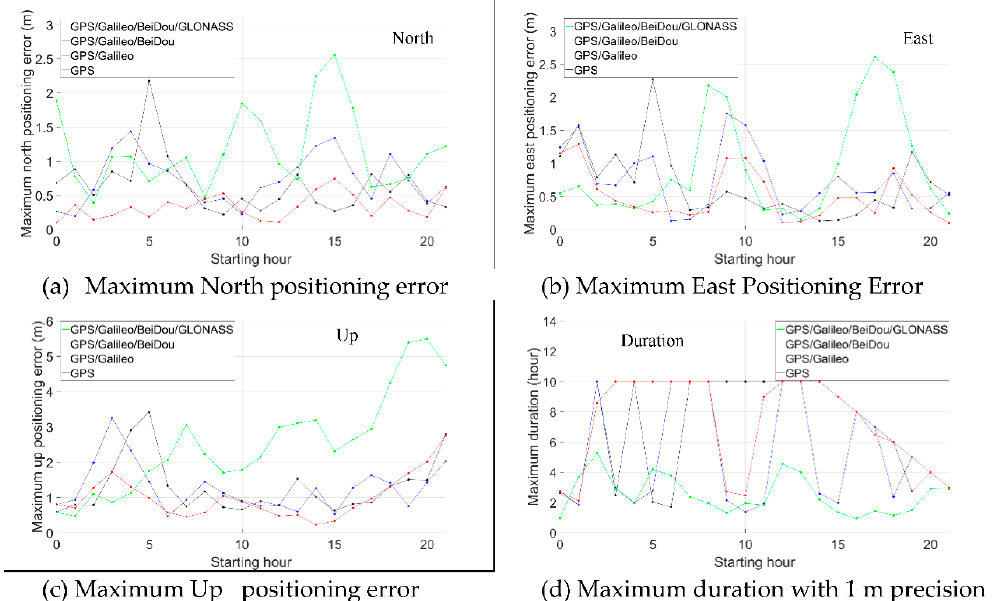
Figure 15. Maximum time-relative positioning error within 3 h ( a : north, b : east, c : up) and ( d ) maximum duration with 1 m precision in both north and east directions of station GOPE.